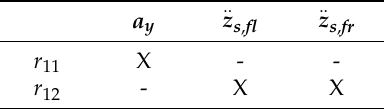
Table 4. Parameters semi-correlation table of roll residuals.